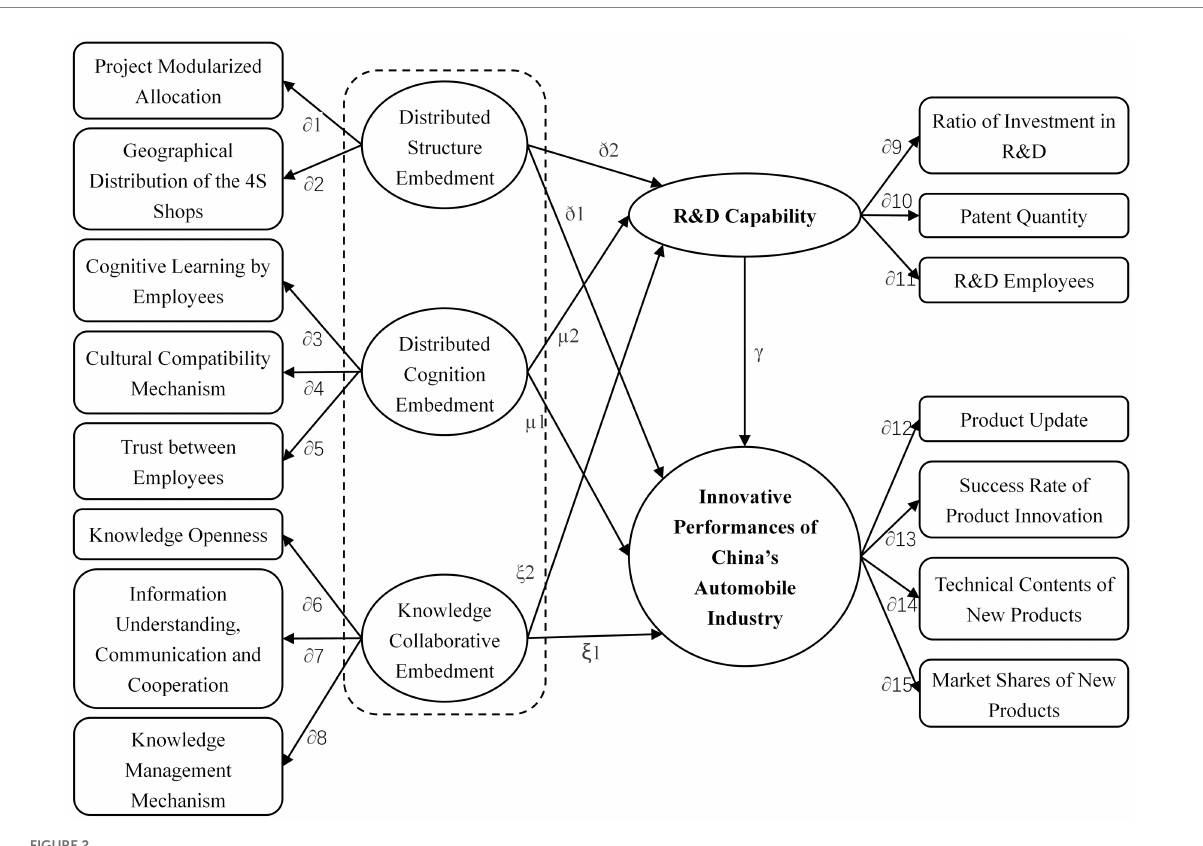
FIGURE 2 Estimated model.